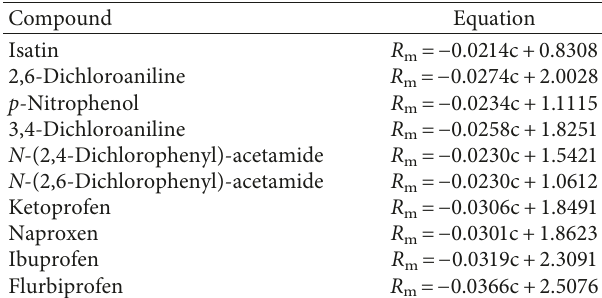
Table 1: The chromatographic equations of the R for the analyzed compounds.